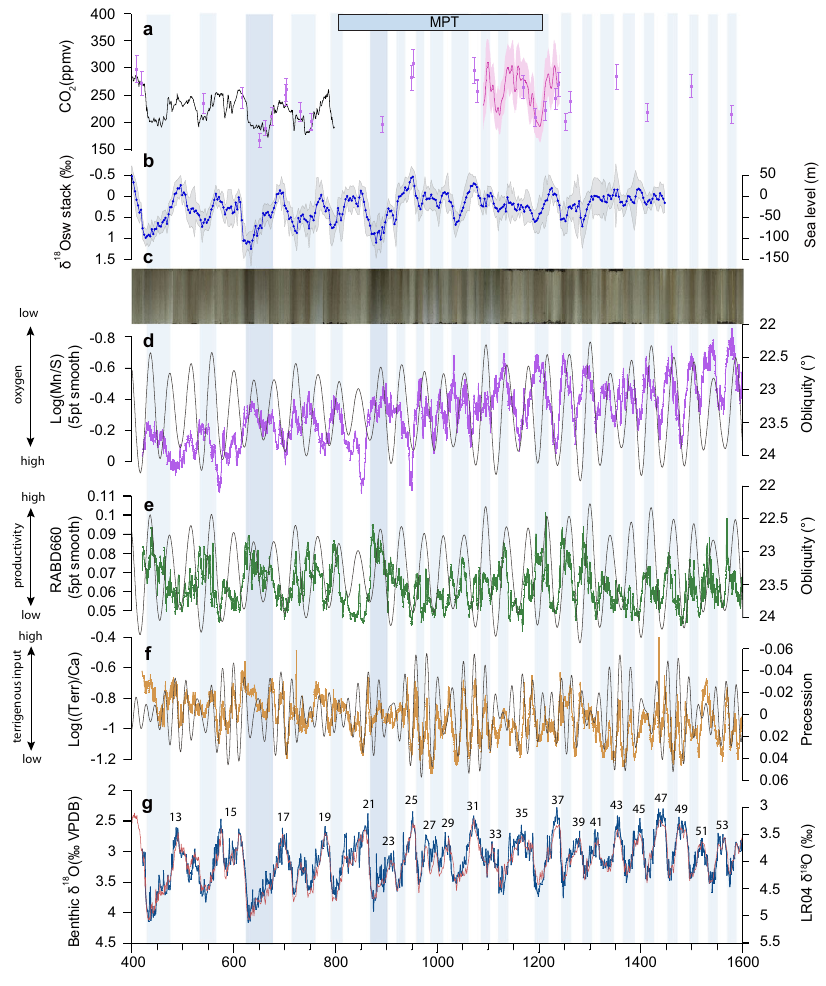
Fig. 2 | ComparisonofAustralianSummer and Winter Monsoonproxy records with atmospheric p CO 2 and sea-level reconstructions between 1.6 and 0.4Ma. a Atmospheric p CO 2 , black: ice core composite record 118 , pink: δ 11 B-based data across the middle Pleistocene Transition (MPT) (with 2 σ error envelope 73 ), purple: δ 11 B record 71 (with 2 σ error). b Sea level reconstruction based on seawater δ 18 O ( δ 18 O sw ) stack (with 1 σ error envelope) from ref. 67. c U1483 composite core line- scan image. d U1483 Log(Mn/S) 5 point moving average (purple) with obliquity